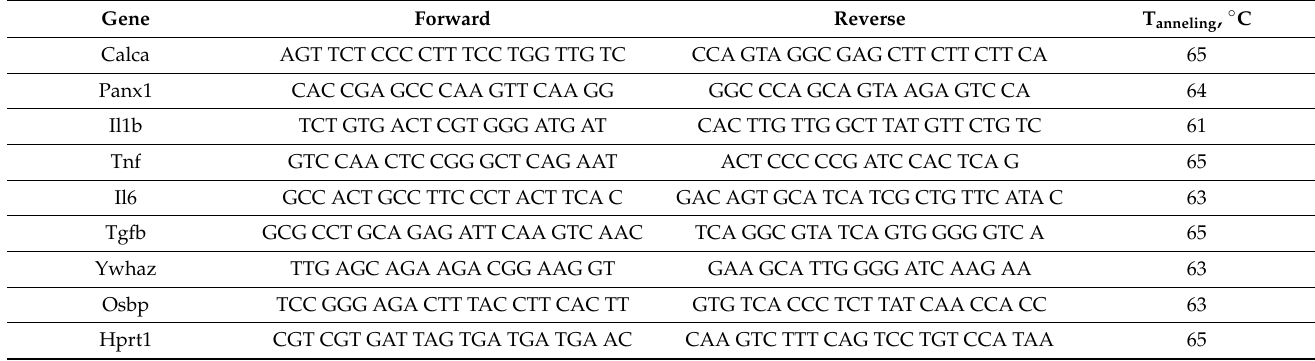
Table 1. Sequences of primers and annealing temperature used for each primer pair (5 ′ > 3 ′ ).